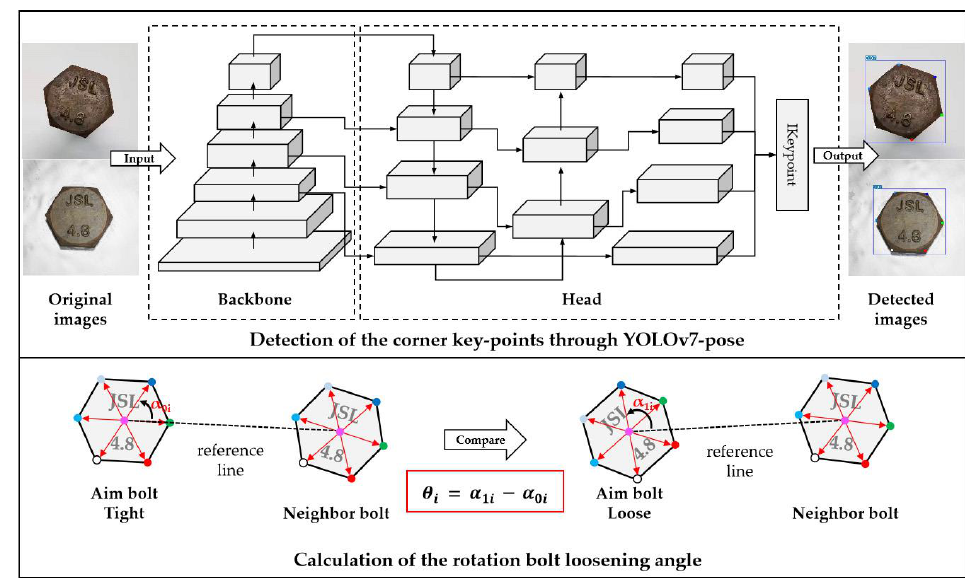
Figure 2. Overview of the bolt loosening angle detection